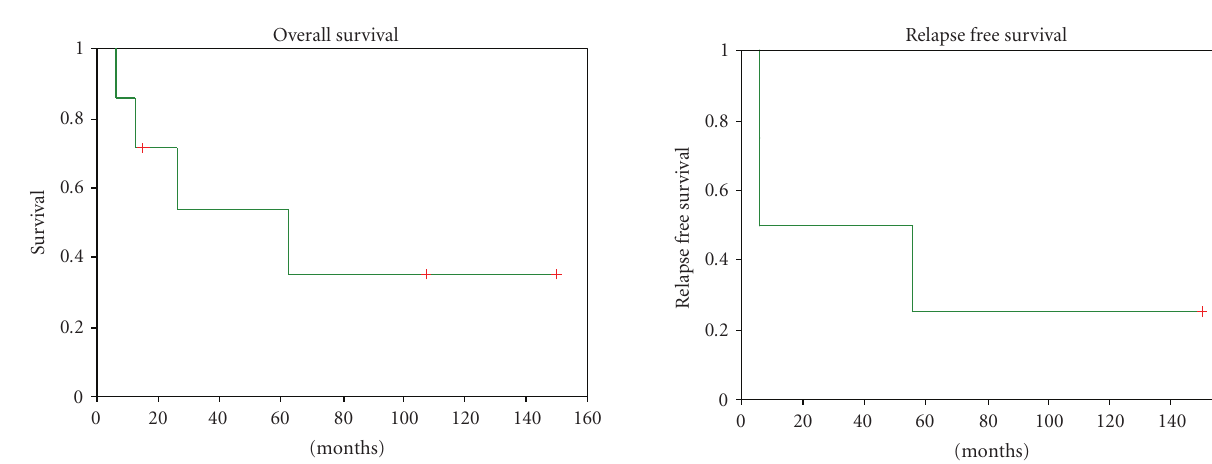
Figure 1: Kaplan-Meier plot of overall survival in all patients. Figure 2: Kaplan Meier plot of disease-free survival in patients with nonmetastatic disease.